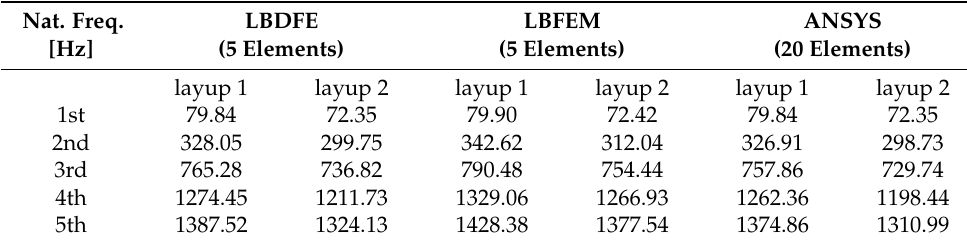
Table 4. First five natural frequencies of cantilevered, preloaded, three-layer, unidirectional composite beams (Layups 1 and 2) in Hertz, obtained from 5-element LBDFE and LBFEM, and